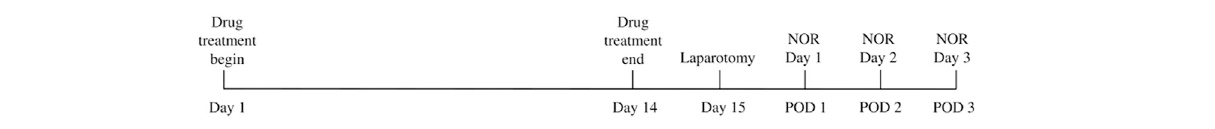
FIGURE 1 | Schematic timeline of the animal experimental